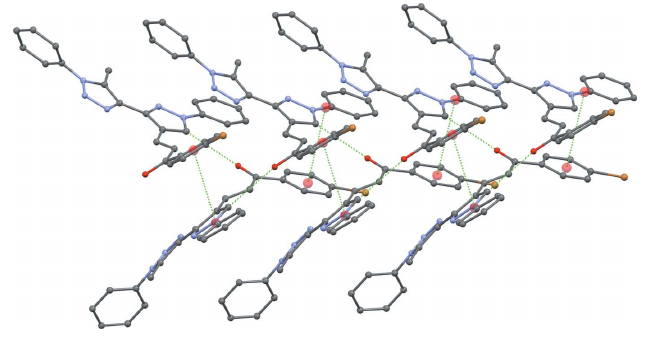
Figure 2 A segment of the crystal structure showing C—H (cid:3)(cid:3)(cid:3) O and (cid:2) – (cid:2)